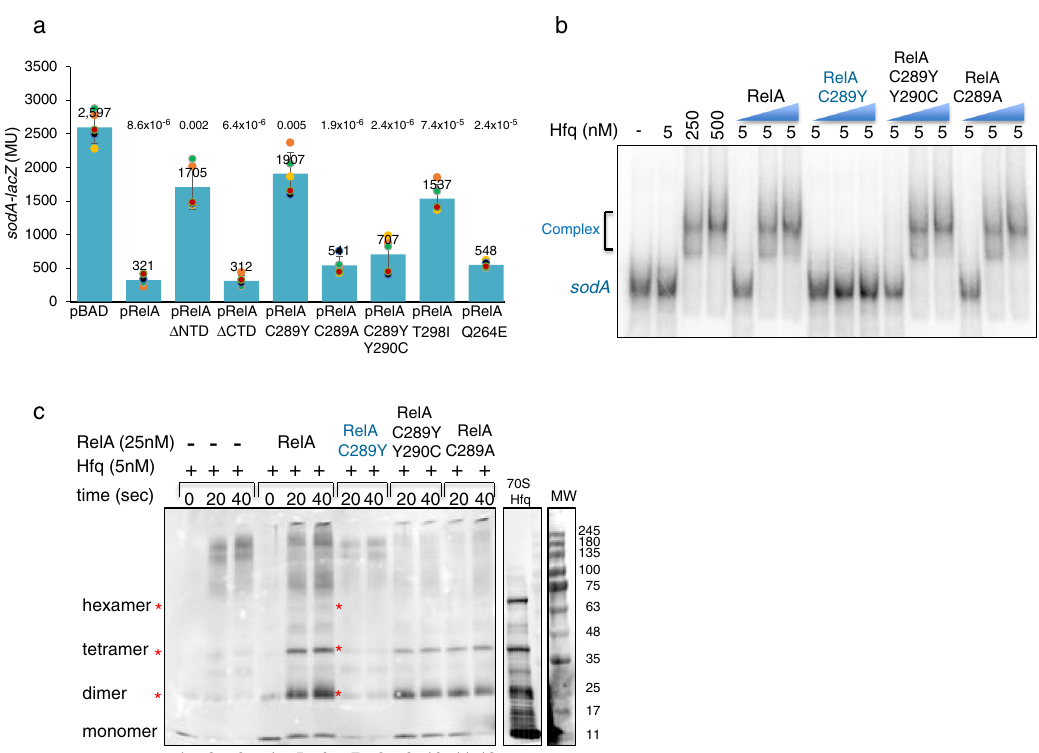
Fig. 1 RelA amino terminus domain induces Hfq assembly. a β -galactosidase assay to determine the effect of plasmids encoded RelA alleles on repression of sodA-lacZ target gene fusion by RyhB. Expression of RelA from BAD promoter was induced with (0.2%) arabinose. n = 5 biological independent samples were examined. Two-tailed unpaired t -test were performed; the absolute p values are indicated. Data are presented as mean values ± SD. b RelA facilitates binding of RNA to Hfq in vitro (EMSA). Gel mobility shift assay of radiolabeled sodA RNA (210 nt; 1 nM) incubated with Hfq without and with 50, 250, and 500 nM of puri fi ed wild type or RelA mutant proteins as indicated (blue triangle). Incubations were carried out at 22 °C for 10 min and the products were separated by 4% native gel electrophoresis. Unbound ( sodA ) and bound (complex) RNA is indicated in the fi gure. c RelA enhances the multimerization of Hfq protein (western). Hfq was incubated with or without puri fi ed RelA proteins for 10 min at 22 °C and samples for zero time point was collected. Thereafter, the products were crosslinked with 0.2% glutaraldehyde at 22 °C. Samples were collected at the indicated time points and the reactions were stopped with 200 mM fresh glycine. The proteins separated in 4 – 20% MOPS gradient gels (GenScript ExpressPlus ™ ) were detected using α Hfq antibody. Asterisk indicate the Hfq multimers. BLUeye Prestained Protein ladder (MW) and 70S ribosomes (4 μ g 70S Hfq 27 ) prepared from wild type cells were loaded as markers to visualize various multimers of Hfq protein. Source data provided as a source data fi active suppressor mutants; RelA:C289A and RelA:C289Y;Y290C enhanced the binding activity of Hfq similar to wild type RelA (Fig. 1b).